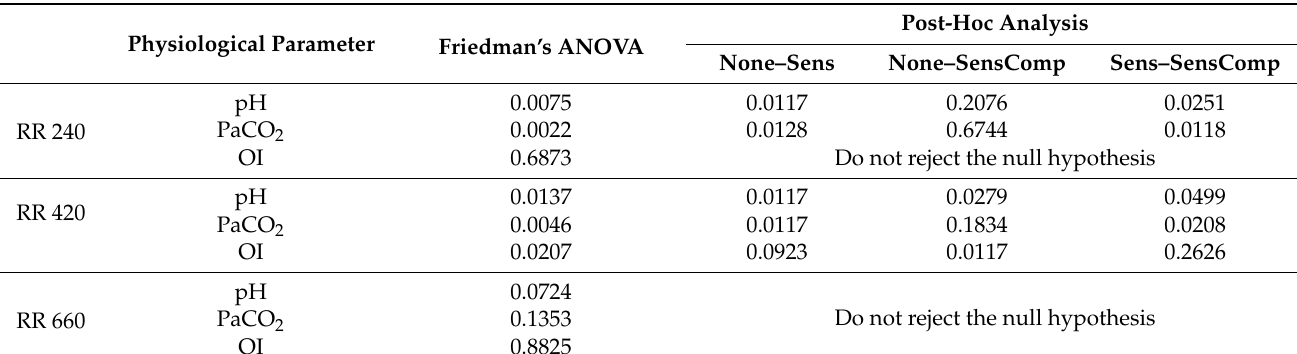
Figure 11. Graphic illustration of monitored parameters of rabbits ( n = 8) at a respiratory rate of 660 breaths/min. Table 1. Results of Friedman test and post-hoc analysis.